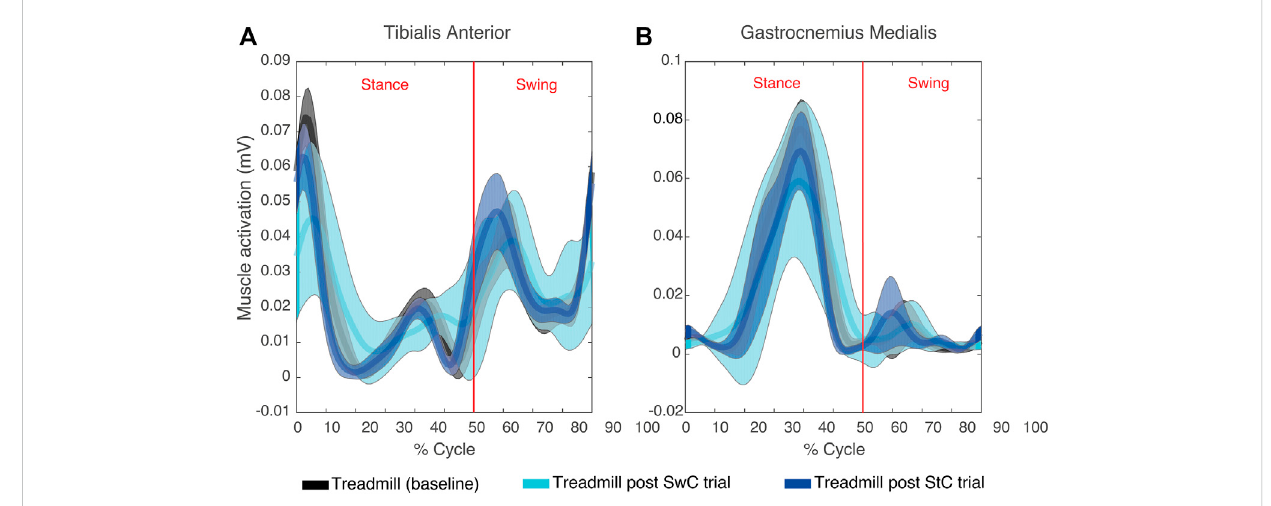
FIGURE 4 Mean (thick lines) and standard deviation (shaded areas) of EMG envelopes from the tibialis anterior (A) and gastrocnemius medialis (B) of a representative subject (ID 09) during the three treadmill trials of the experimental session. Vertical red lines divide stance and swing phases.